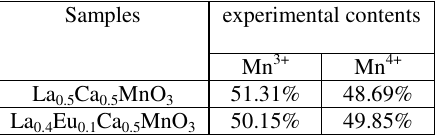
Table 1: Chemical analysis results for La 0.5 Ca 0.5 MnO 3 and La 0.4 Eu 0.1 Ca 0.5 MnO 3